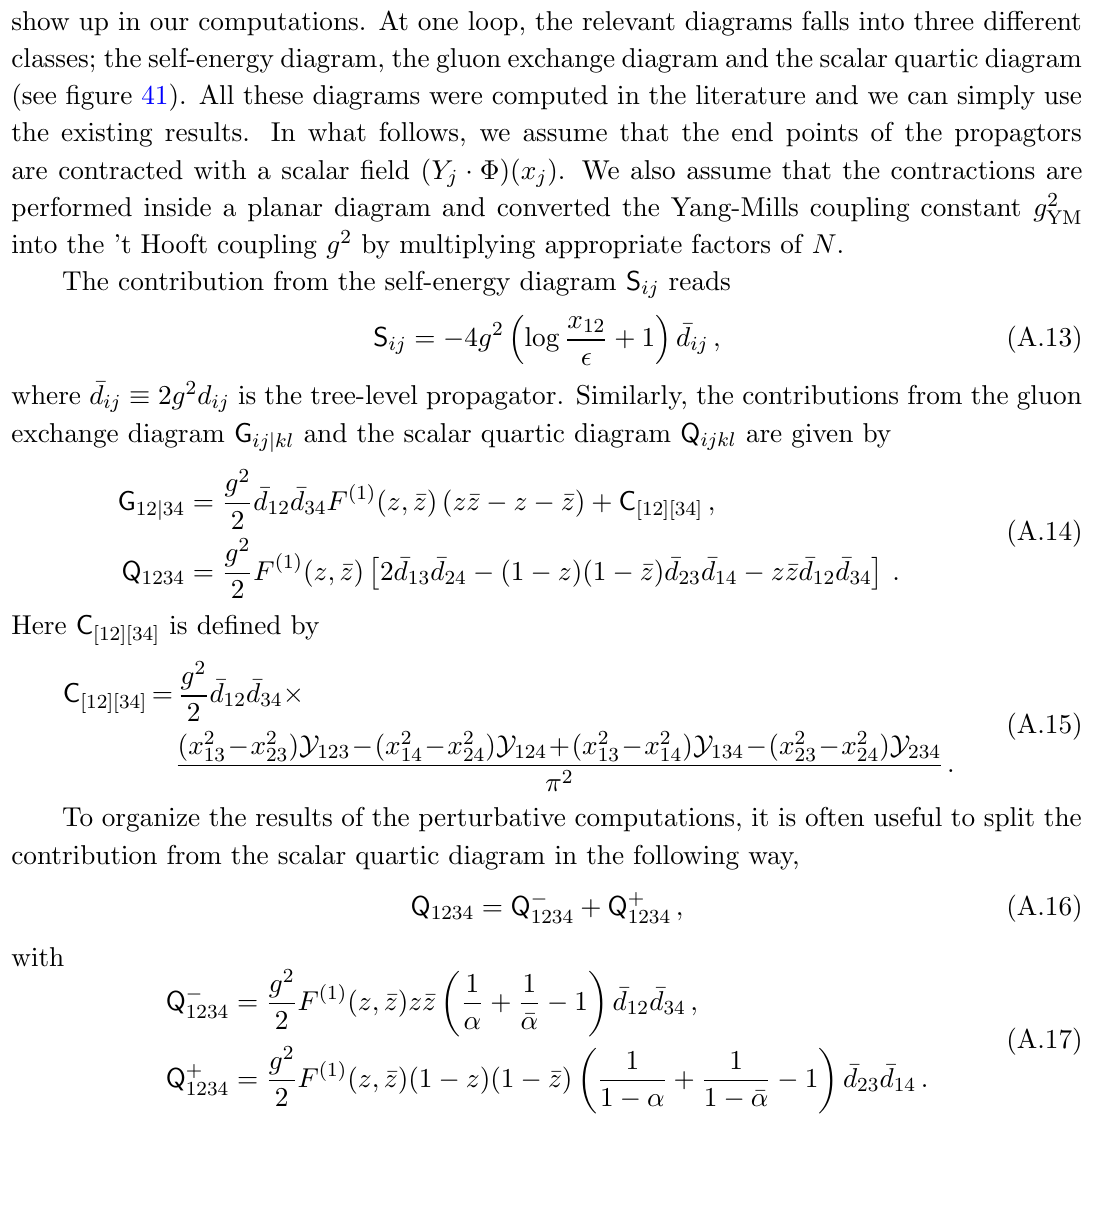
Figure 41 . The self-energy diagram, the gluon exchange diagram and the scalar quartic diagram. One-loop